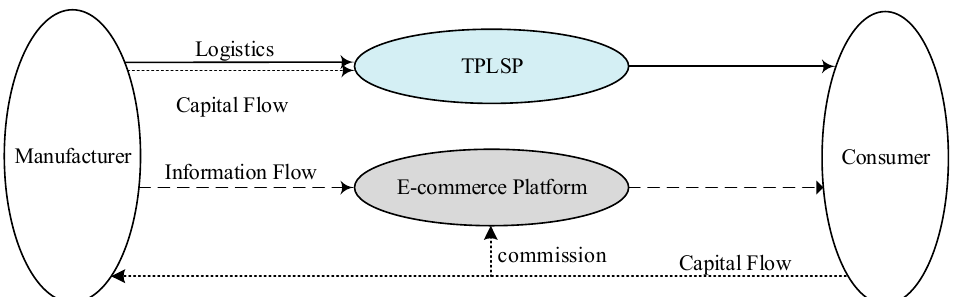
Figure 1. Model structure of electronic commerce supply chain (ESC) under logistics outsourcing.